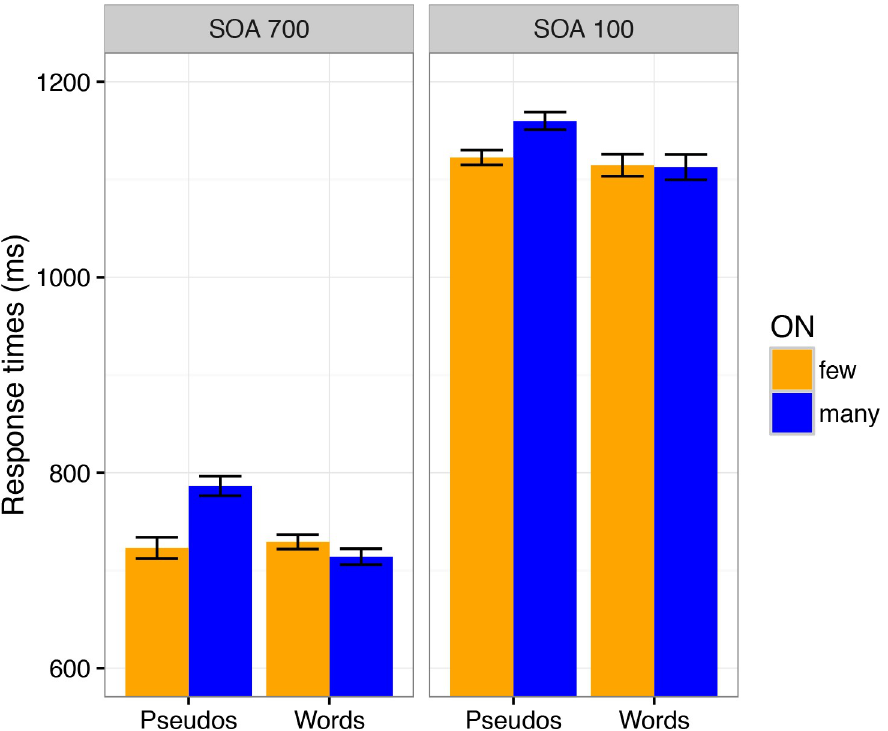
Fig 2. Response times as a function of stimulus onset asynchrony (SOA), lexicality (words versus pseudowords) and orthographic neighborhood size (ON). Error bars show SEMs after removal of the irrelevant overall between- subject differences (based on [68]).